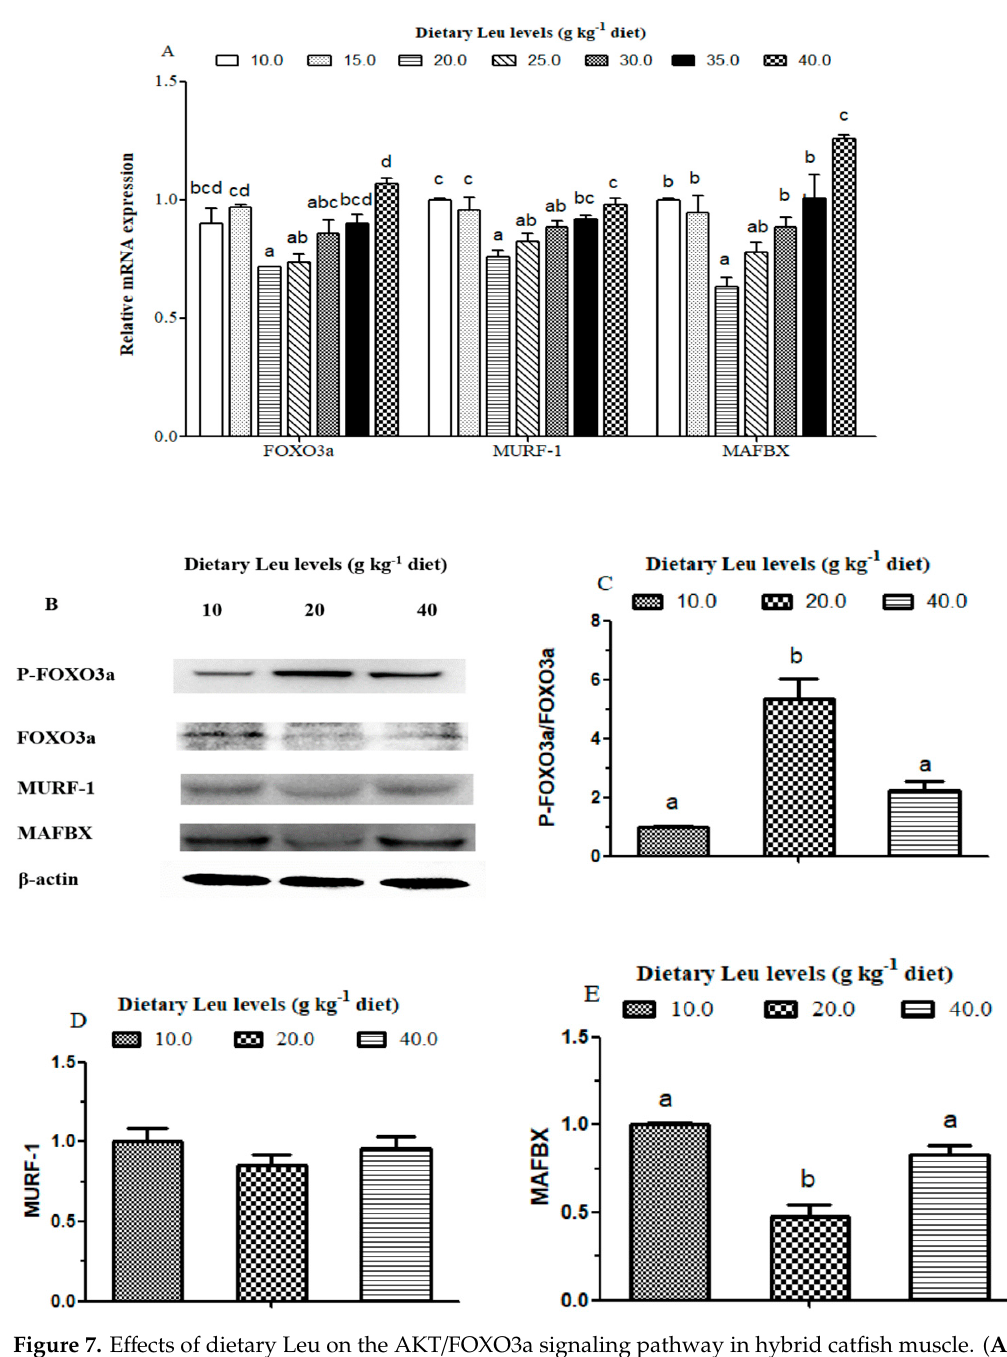
Figure 7. E ff ects of dietary Leu on the AKT / FOXO3a signaling pathway in hybrid catfish muscle. ( A ) E ff ect of dietary Leu on FOXO3a, MURF-1, and MAFBX mRNA expressions in muscle of hybrid catfish. ( B ) E ff ect of dietary Leu on the protein expressions of P-FOXO3a (Ser253), FOXO3a, MURF-1, and MAFBX in muscle of hybrid catfish. Results were expressed as the ratio of P-FOXO3a and FOXO3a ( C ), MURF-1 ( D ), and MAFBX ( E ) protein levels. Data represent means ± SEM of three replicates, with six fish in each replicate. Values having di ff erent letters are significantly di ff erent ( P <